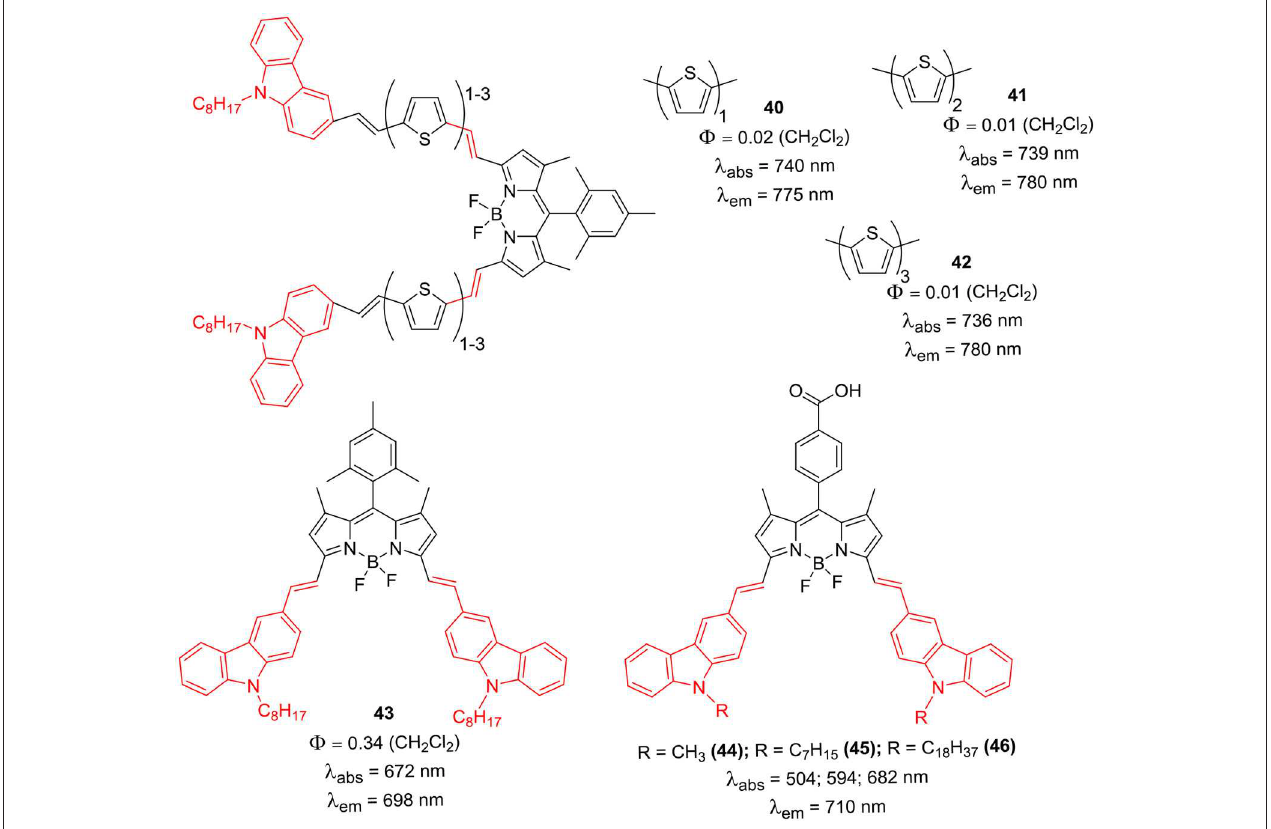
CHART 3 | α -styryl linked carbazole